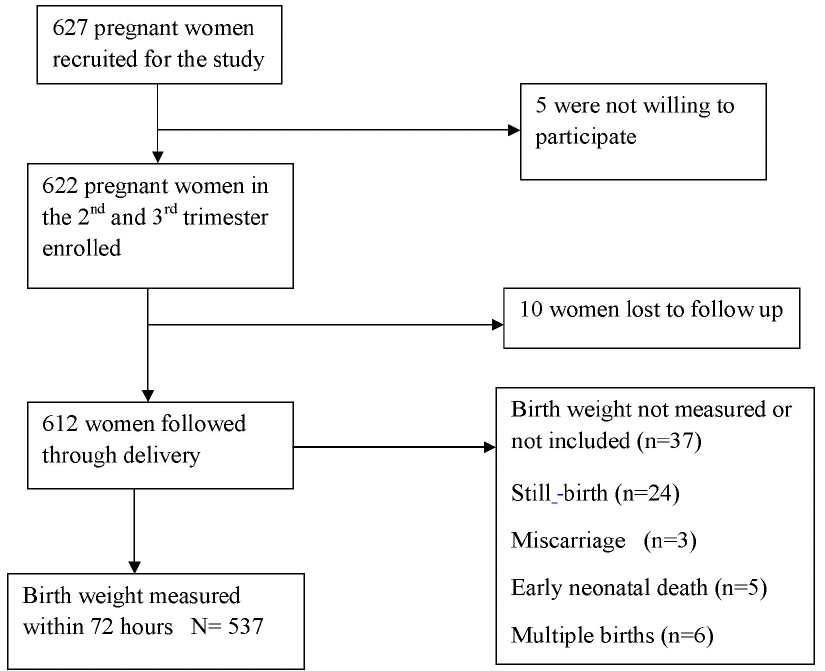
Figure 1. Flowchart showing the cohort and birth weight measurement, Southwest Ethiopia, 2012.